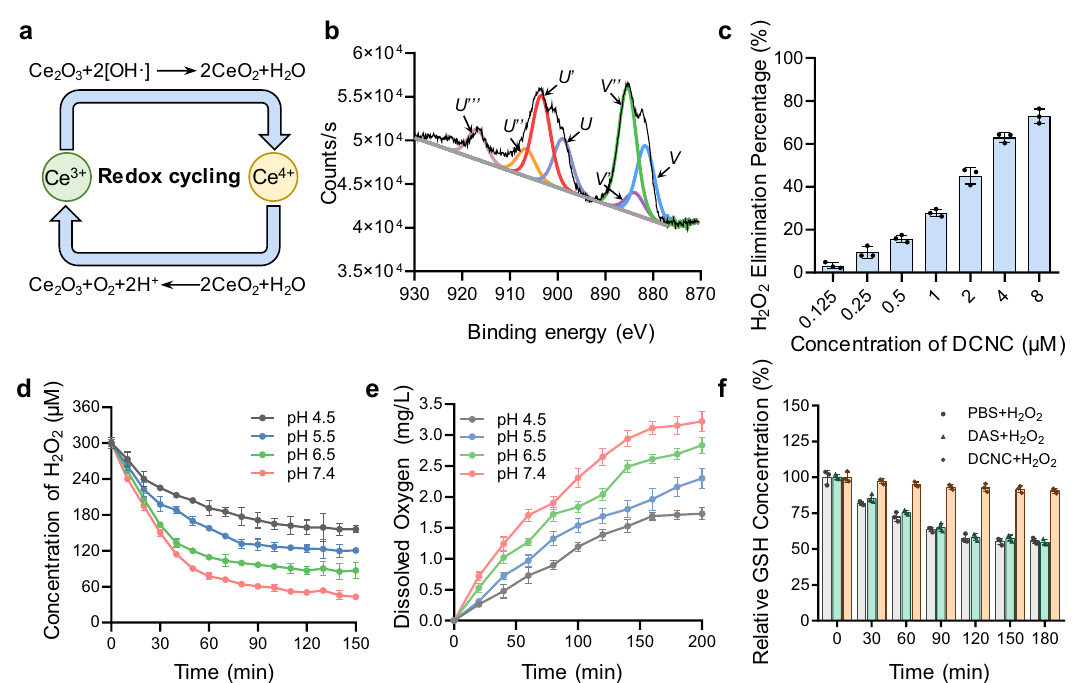
Fig. 3 | Evaluation of the catalytic activity of DCNC. a Schematic illustration of reaction mechanism of H 2 O 2 decomposition by DCNC. b XPS analysis of the che- micalvalenceofceriuminDCNC. c EliminationofH 2 O 2 byvariedconcentrationsof DCNC. d Decomposition of H 2 O 2 at varied pH by the catalysis of DCNC in aqueous